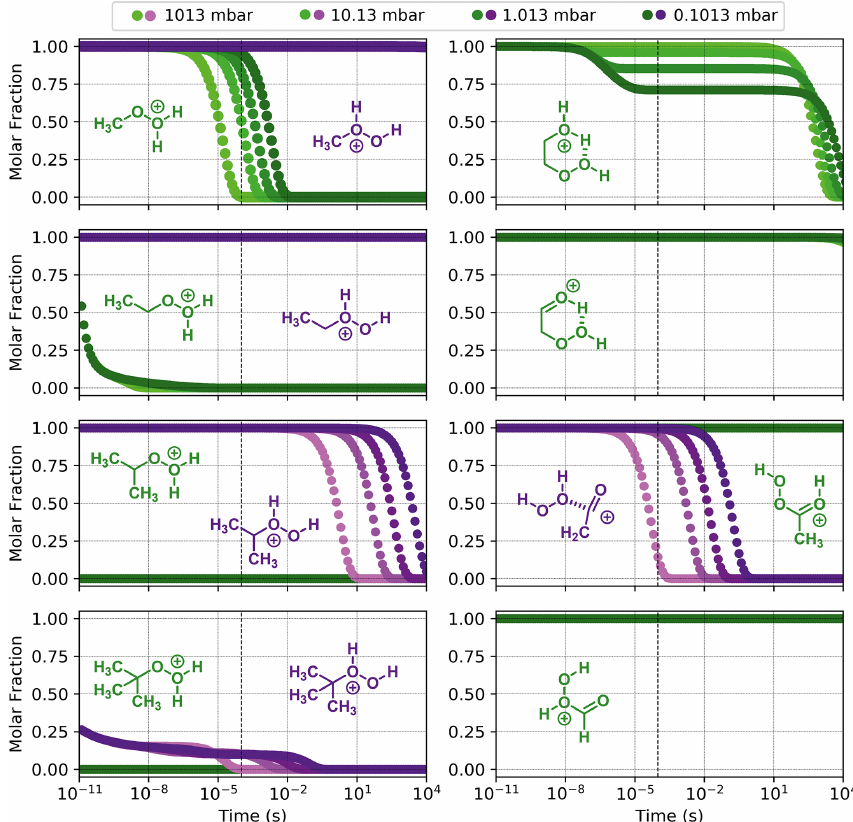
Figure 7. Reaction dynamics simulation results for model ROOH systems. Graphs represent the time evolution profile of fragmentation of initial protonated reactants at 298.15K. Left-hand side, from top to bottom: (MeOOH)H + , (EtOOH)H + , (iPrOOH)H + , and (tButOOH)H + ; right-hand side, from top to bottom: (HOEtOOH)H + , (O = EtOOH)H + , (AcOOH)H + , and (OCHOOH)H + . When two protonation isomers that do not readily interconvert are possible, they are plotted in the same graph with different colours (green and purple). Dashed line indicates 100µs from the start of the